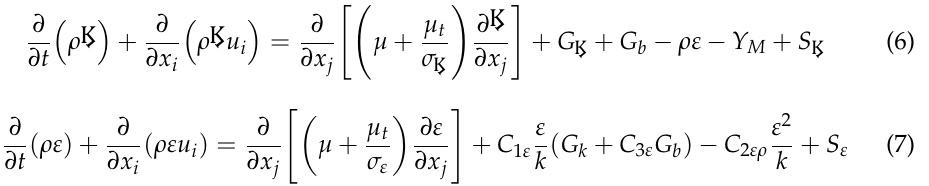
Figure 2. Lattice heat sink mesh.